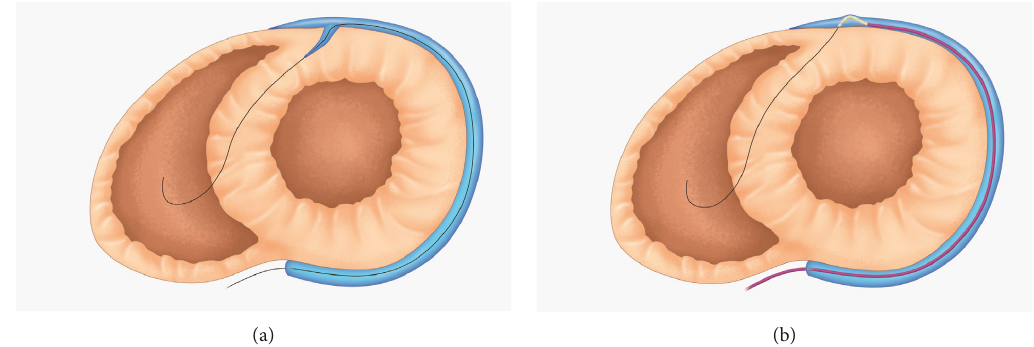
Figure 1: The conceptual illustration of (a) the guidewire engaging the myocardium of patients through the septal vein and (b) the role of the Cobra catheter in patients without a septal